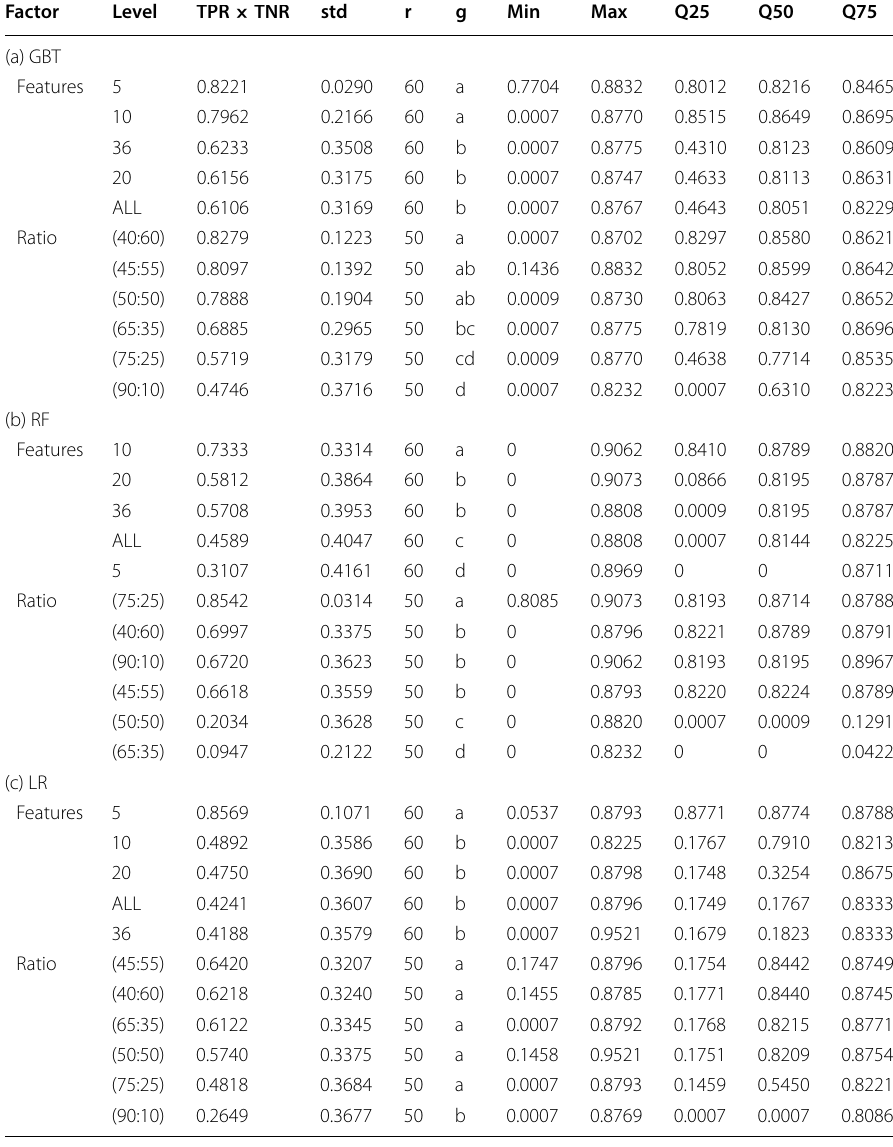
Table 6 Tukey HSD test—POST